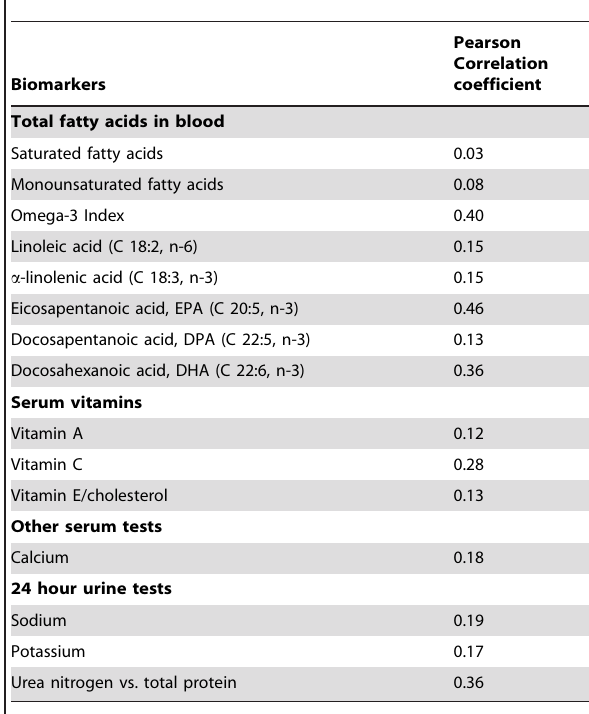
Table 5. Validity of intake of some nutrients with DH-E2 (at 12 months from baseline) versus biomarkers (mean of measurements at 0, 6 and 12